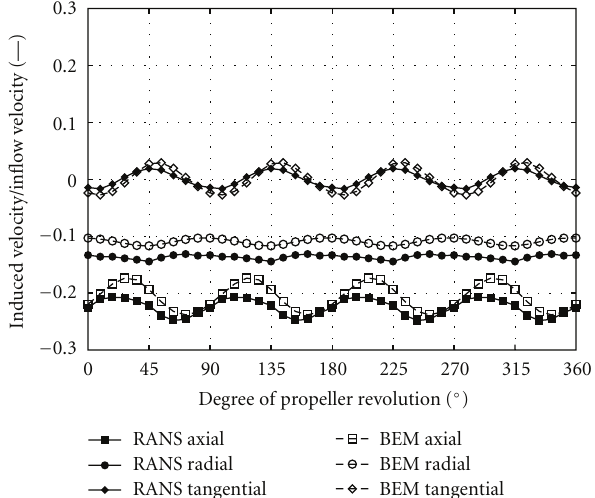
Figure 11: Comparison of normalised induced velocities for a four- bladed propeller (explicit coupling: r/R = 0 . 7, J = 0 . 5, dt · n = 3 . 78 ◦ , dx = 0 . 5 R ).